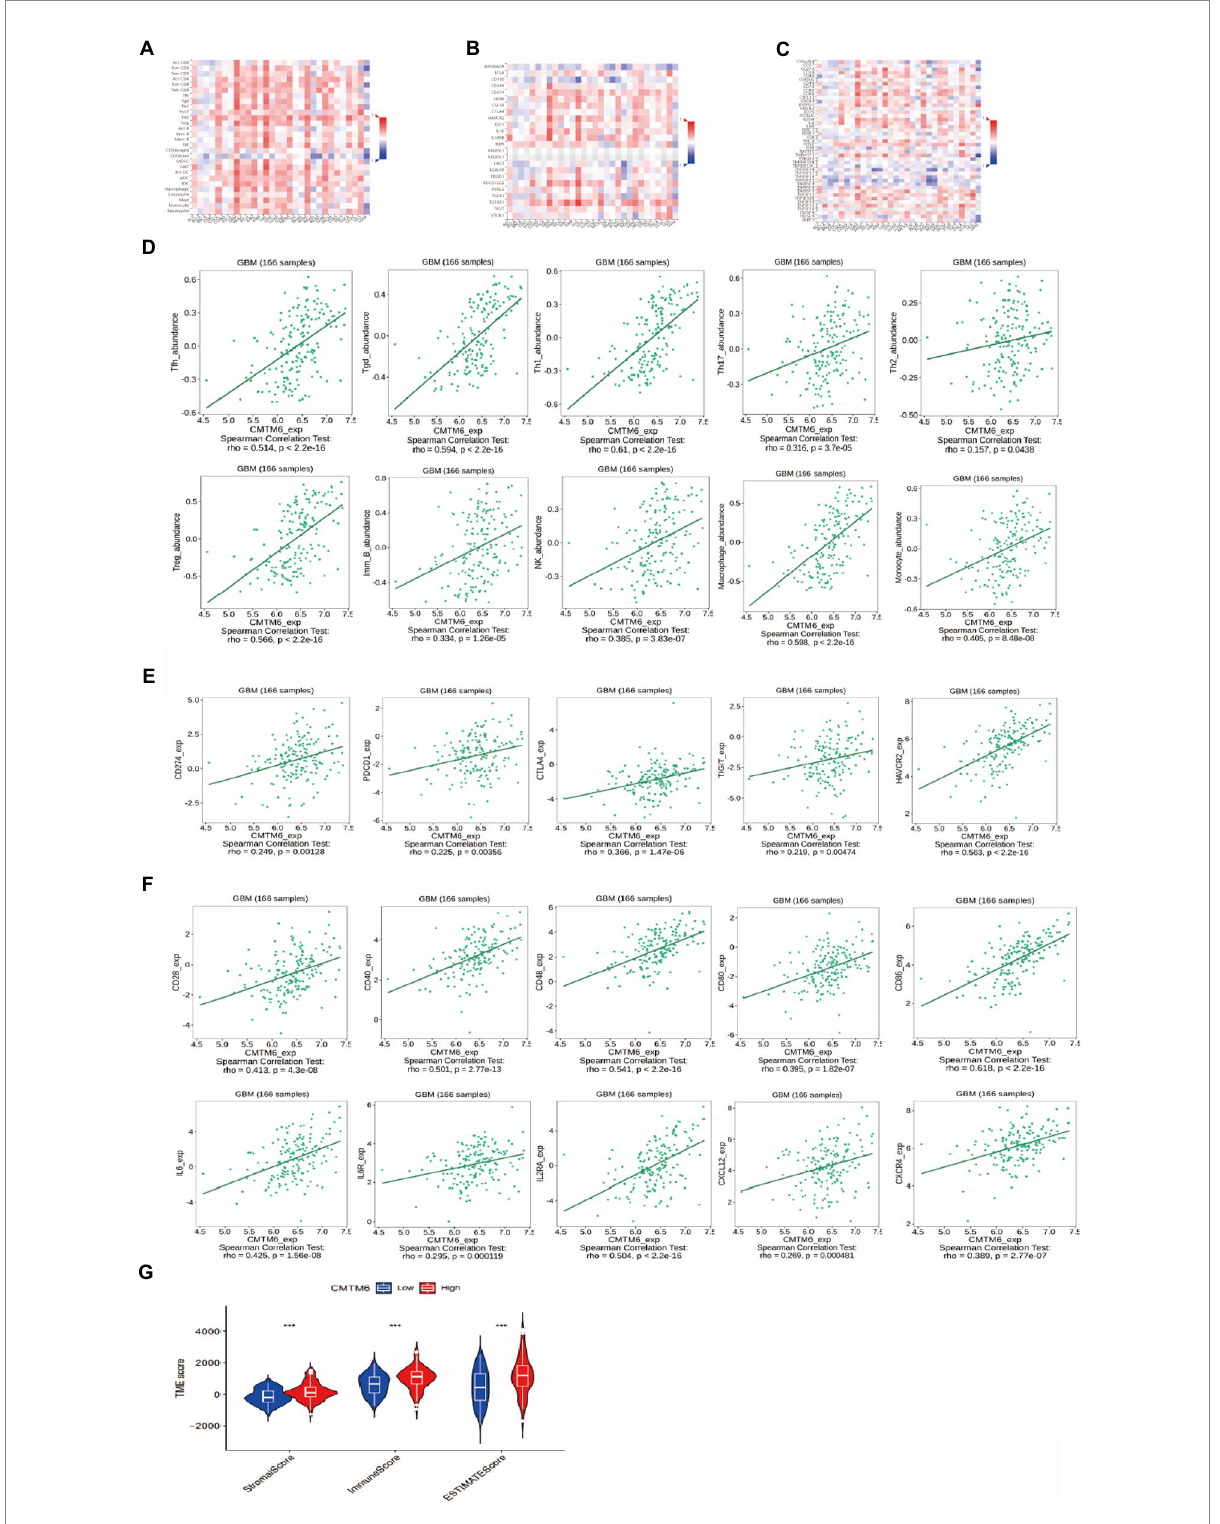
FIGURE 3 The relationship of CMTM6 with tumor-infiltrating lymphocytes (TILs), immunoinhibitors, immunostimulators and immunescore. (A) Heatmap of the relationship between CMTM6 and immune cells in tumors (TISIDB). (B) Heatmap of the relationship between CMTM6 and immunoinhibitors in pan-cancer (TISIDB). (C) Heatmap of the relationship between CMTM6 and immunostimulators in pan-cancer (TISIDB). (D) Correlation of CMTM6 with immune cells in GBM (TISIDB). (E) Correlation plot of CMTM6 and immunoinhibitors in GBM (TISIDB). (F) Correlation plot of CMTM6 with immunostimulators in GBM (TISIDB). (G) The relationship between CMTM6 and immunescore in GBM